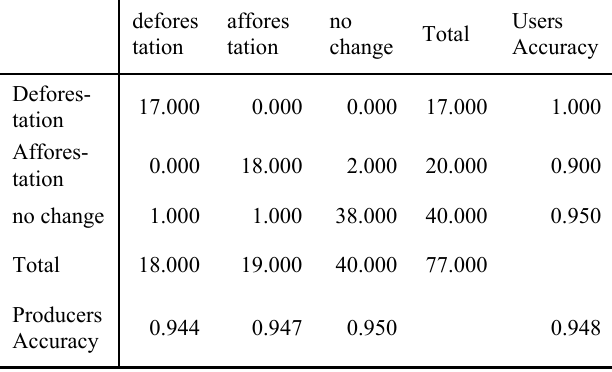
Table 2. Confusion Matrix